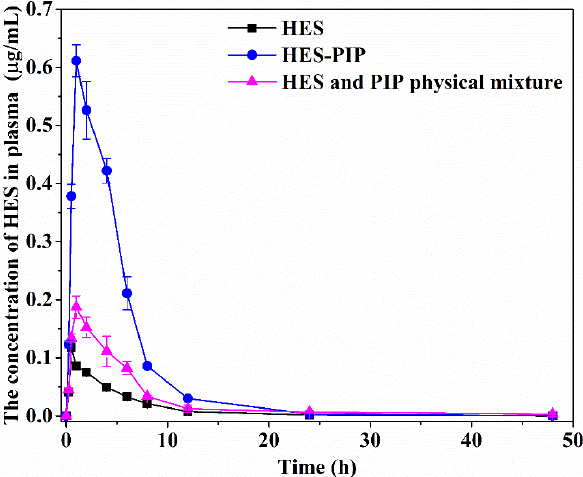
Figure 7. Pharmacokinetic profile of HES, HES–PIP, and the physical mixture of HES and PIP. Table 3. Main pharmacokinetic parameters of free HES, HES–PIP cocrystal, and HES + PIP (physical mixture) in vivo ( n = 6).